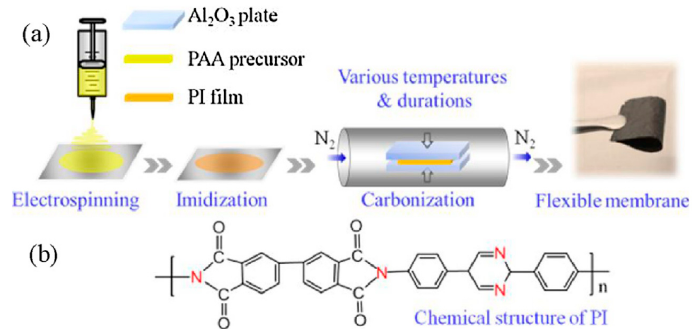
Figure 7. ( a ) Schematic illustration of the fabrication process of flexible self-standing paper-like carbon membrane by the use of polyimide (PI), obtained via imidization from polyamic acid (PAA) precursor. ( b ) Chemical structure of PI with biphenyl and pyrimidine rings (reproduced from reference [80] with permission. Copyright 2018, Elsevier).